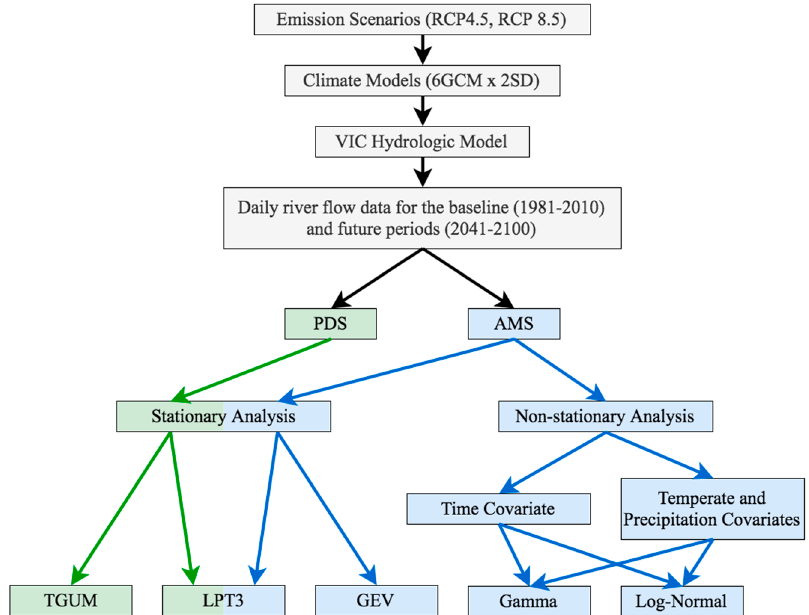
Figure 6. General flowchart showing all the different steps and combinations in hydrologic model simulation and statistical analysis of peak flows in the Athabasca River. GEV, generalized extreme value; PDS, partial duration series; LPT3, log-Pearson type 3; TGUM, Truncated Gumbel.